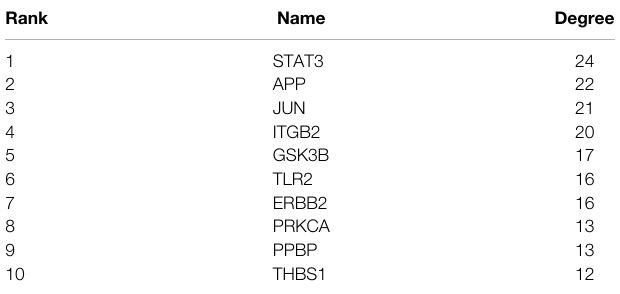
TABLE 3 | Top 10 in network ranked by Degree method.